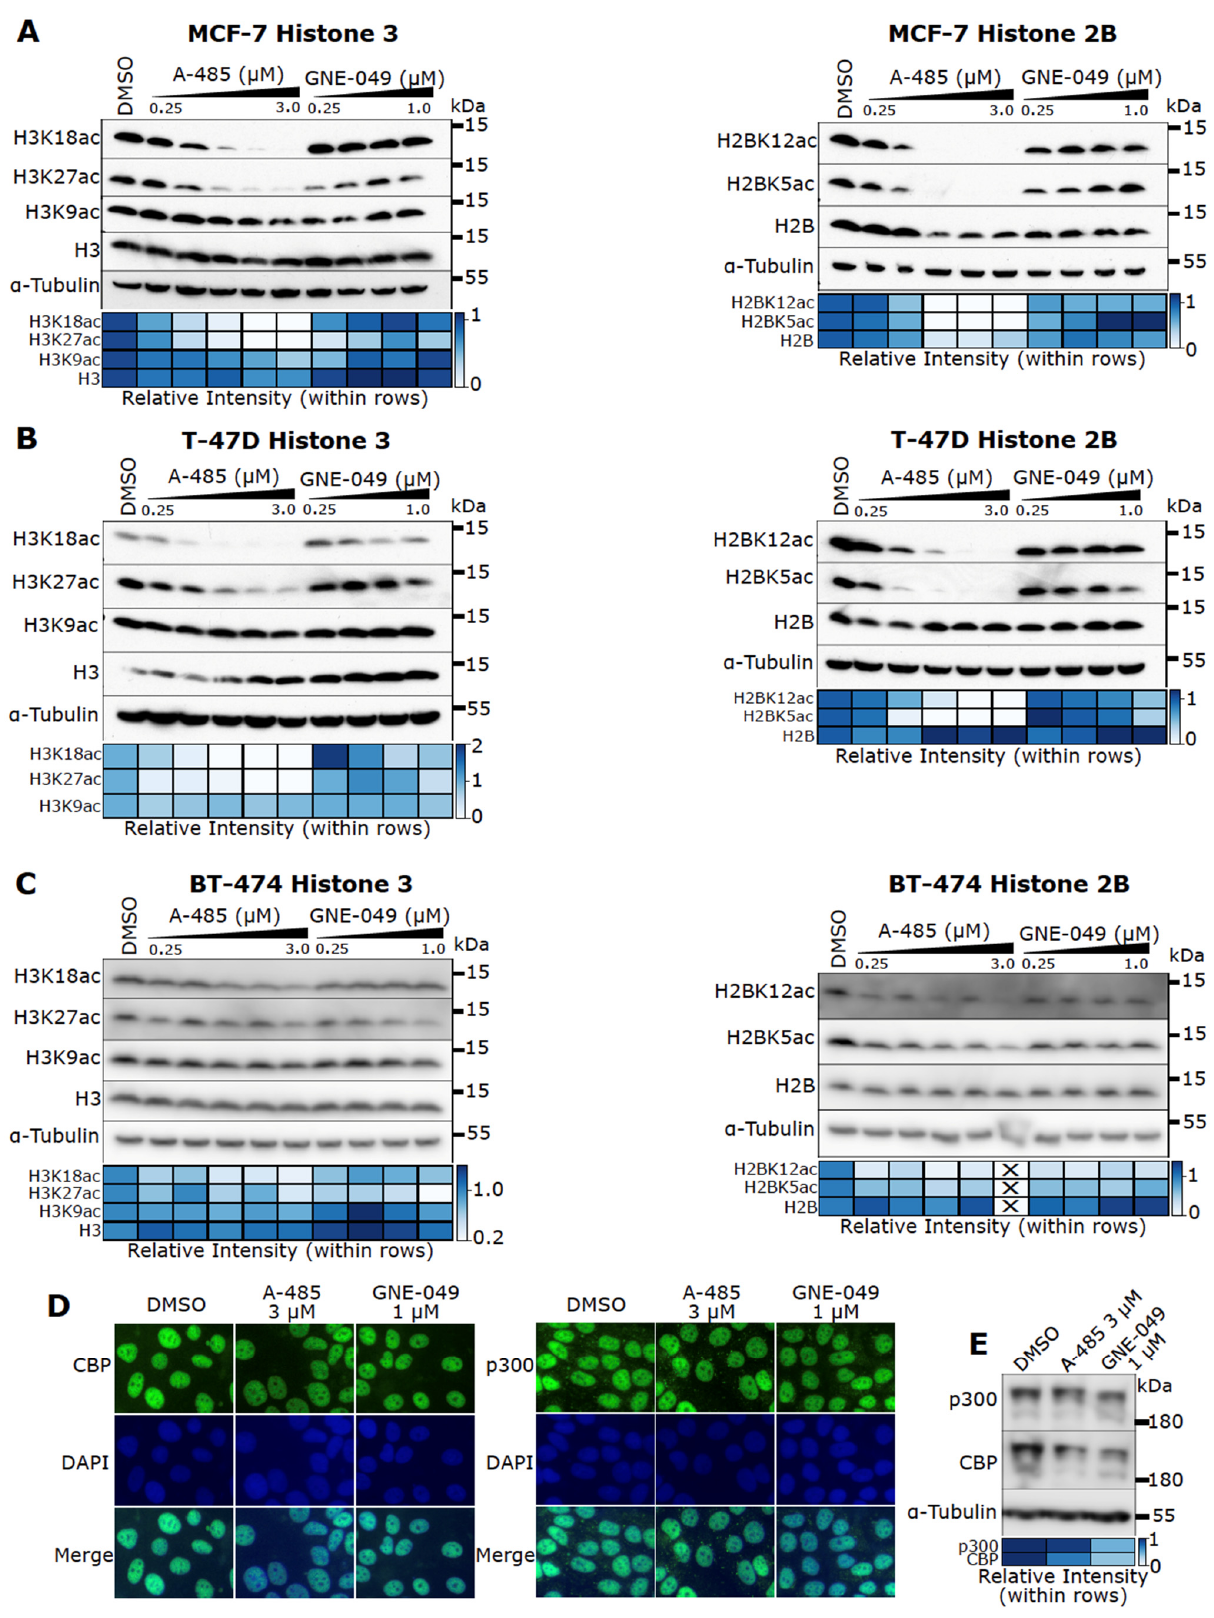
Figure 4. Inhibition of specific histone acetylation by A-485 and GNE-049 in ER+ BC cells. ( A – C ) MCF-7 ( A ), T-47D ( B ), and BT-474 ( C ) cells were treated with A-485 and GNE-049 for 24 h before cell lysis. Acetylation at specific H3 (left) and H2B